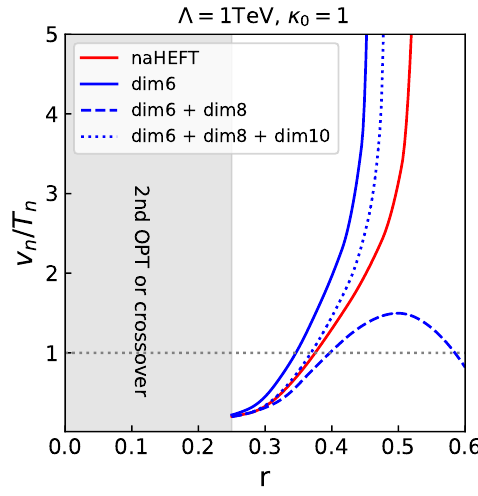
Figure 3 . v n /T n estimated by our EFT without finite temperature corrections from new physics (red), the effective potential approximated up to the dimension six (blue), eight (dashed blue), and ten (dotted blue) operators. We take Λ = 1 TeV and κ 0 = 1 .